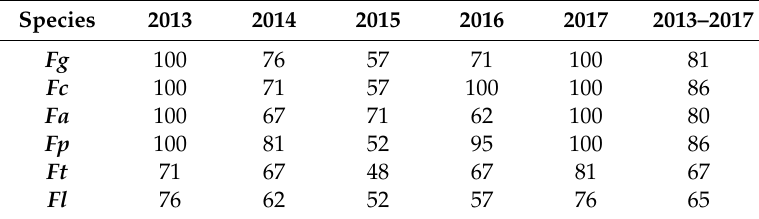
Table 2. Percentages of wheat grain samples infected with F. graminearum ( Fg ), F. culmorum ( Fc